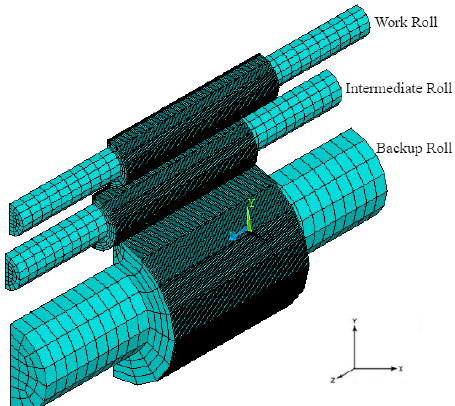
Figure 1. Universal Crown Mill with Work roll shifting (UCMW) roll system finite element model. Table 1. The main parameters of roll system.